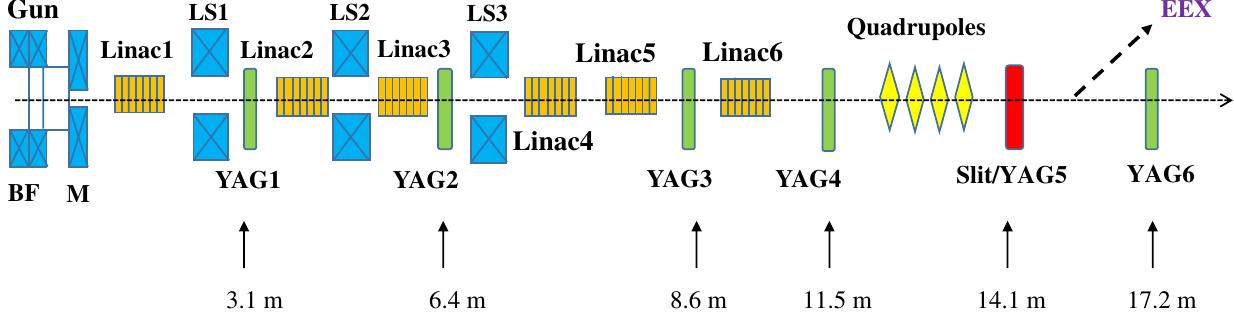
FIG. 5. Overview of the AWA-DB beam line only showing elements relevant to the performed experiment. Bucking-focusing (BF) and matching (M) solenoids were adjusted to image the beam on YAG screens. Linac solenoids (LS) and quadrupoles were turned off during the experiment. The positions of the YAG viewers are denoted in meters. The energy gain of one accelerating cavity (linac) is 10 MeV. EEX label marks the separate double-dogleg beam line for emittance exchange